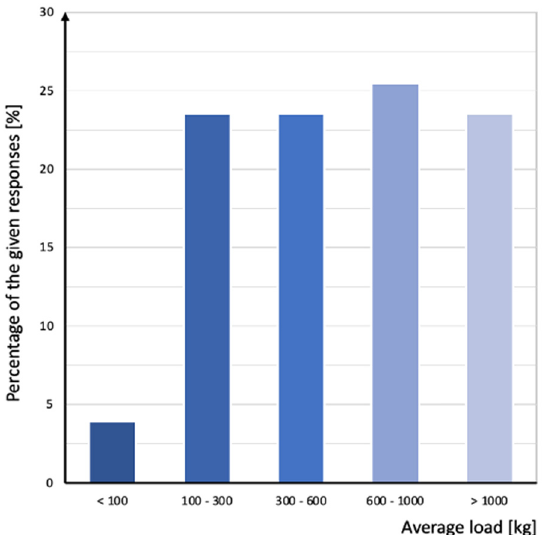
Figure 5. The average load at the beginning of a workday (based on own survey).